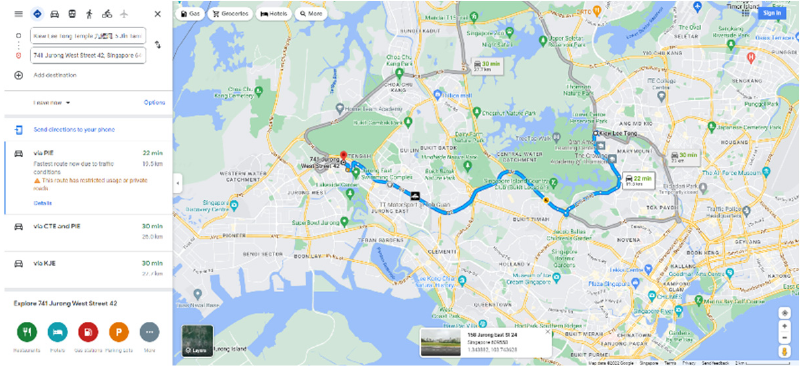
Figure 1. Driving distance between Kiew Lee Tong ( 九鲤洞 ) and Qiong Yao Jiao Di ( 琼瑶教邸 ) in 1979.